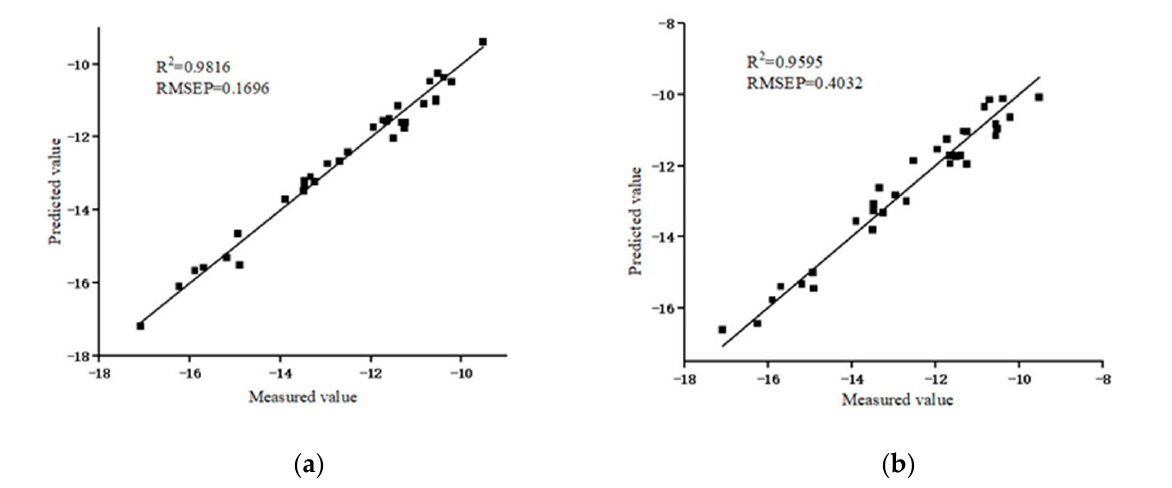
Figure 5. ( a ) Scatter plot of measured and predicted greenness value based on fluorescence spectral model; ( b ) scatter plot of measured and predicted greenness value based on hyperspectral model. The R 2 and RMSEP of the tomato leaf greenness value prediction model based on the fluorescence spectrum were 0.9816 and 0.1696, respectively, while those of the model based on the hyperspectrum were 0.9595 and 0.4032, respectively (Figure 5). These results demonstrated that the prediction model was suitable and predicted results with acceptable accuracy. However, the model based on the fluorescence spectrum had a higher R 2 and a smaller RMSEP, indicating the prediction accuracy of this model was better. According to the measured greenness value and the predicted greenness value ob- tained by the two models, a comparison chart of the predicted greenness values of the two models was established (Figure 6). Combining the R 2 and RMSEP of the prediction model, the comparison chart analyzed the prediction results of the greenness value obtained by the models established on the basis of the two spectrums; the results showed that they reached a prediction accuracy of more than 95%, and the fluorescence spectrum regression model was obtained. The predicted value was closer to the actual measured value, indicating that the fluorescence spectroscopy technique was more accurate.